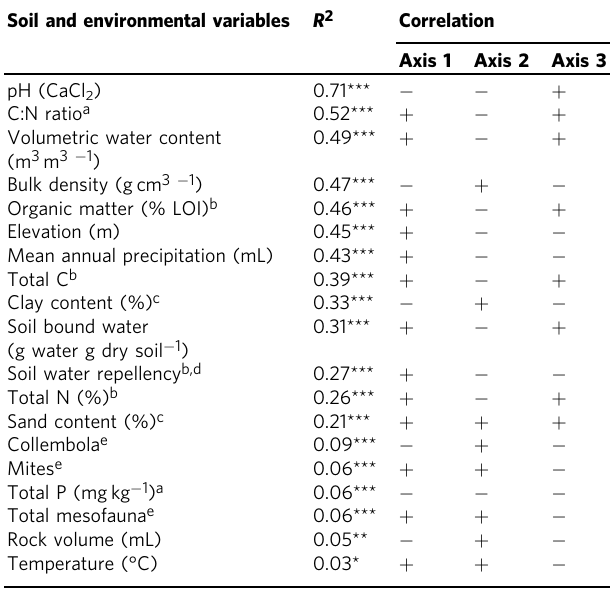
Table 2 Summary of relationships amongst environmental factors and bacteria communities Soil and environmental variables R 2 Correlation